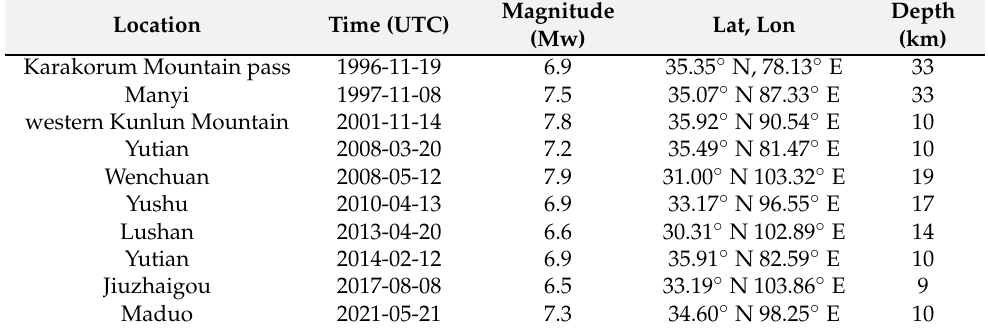
Table 1. Historical earthquakes of magnitude >6.5 in mainland China in the past 25 years. Location Time (UTC)